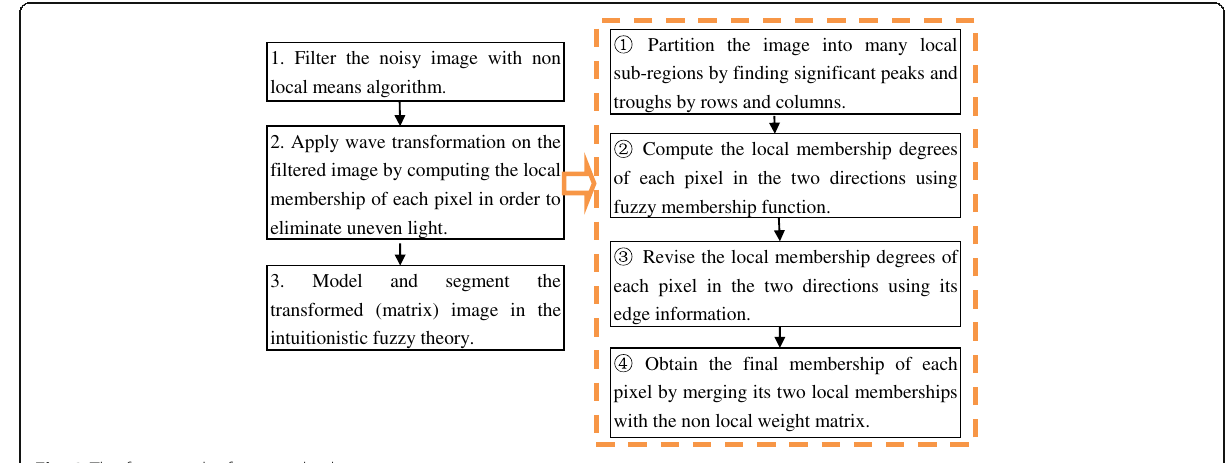
Fig. 3 The framework of our